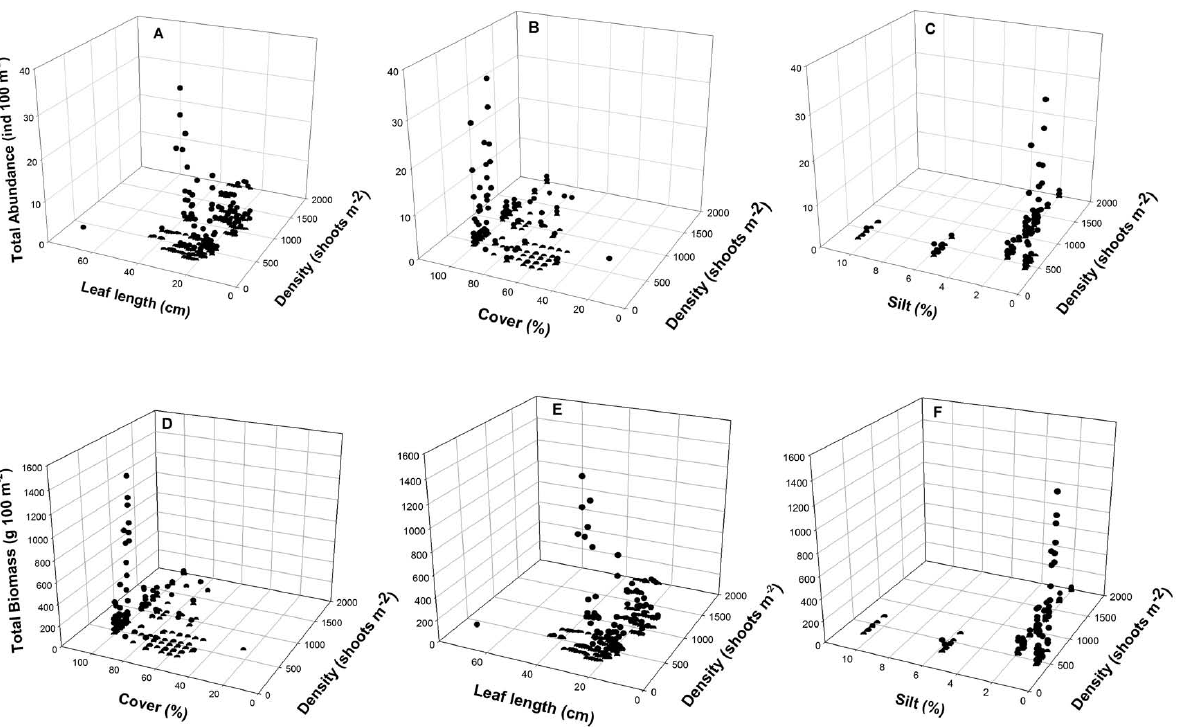
Fig. 4. – Relationships between total abundance (A-C) and biomass (D-F) of the pearly razorfish, Xyrichtys novacula , recorded through UVCs, and the structural elements of the